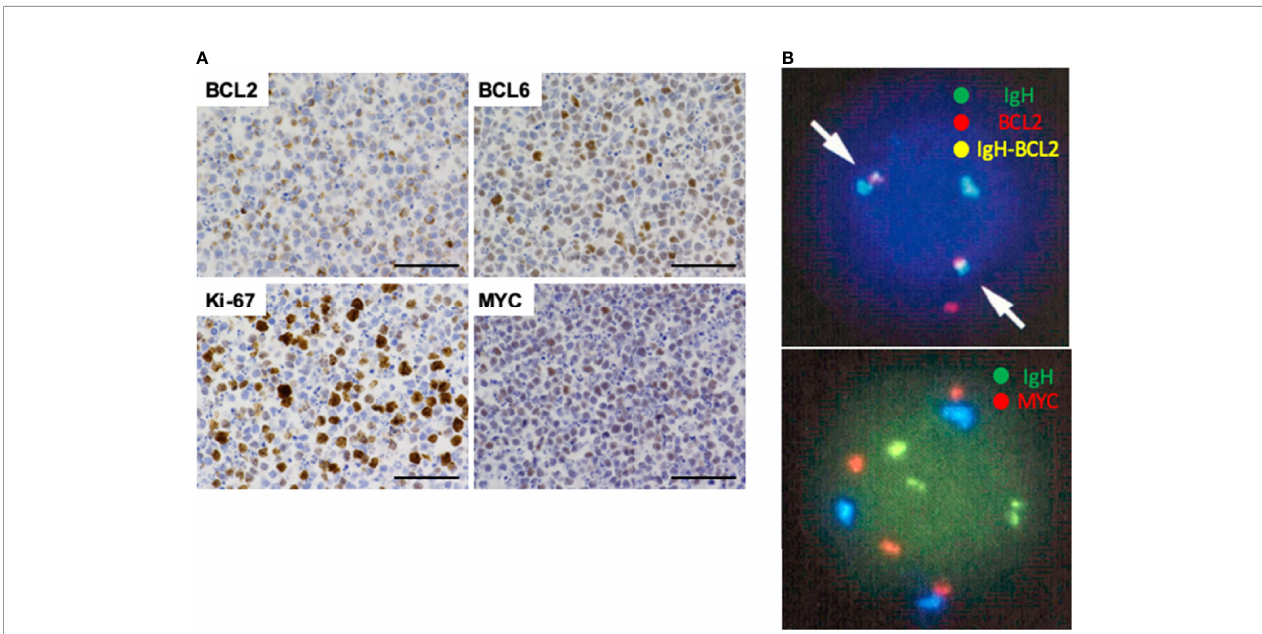
FIGURE 4 | Immunohistochemical analyses and fl uorescence in situ hybridization of ascitic fl uid cell block samples. (A) Neoplastic lymphocytes were positive for BCL2, BCL6, and MYC. The percentage of Ki-67-positive cells was 70%. Scale bar, 50 m m. (B) Ascitic fl uid cells were subjected to fl uorescence in situ hybridization (FISH). FISH detected formation of BCL2/IgH fusion signal (arrows, yellow color) in 99 cells among analyzed 100 cells (top). Gain of MYC signal (red color) was seen in 97 cells among analyzed 100 cells (bottom).